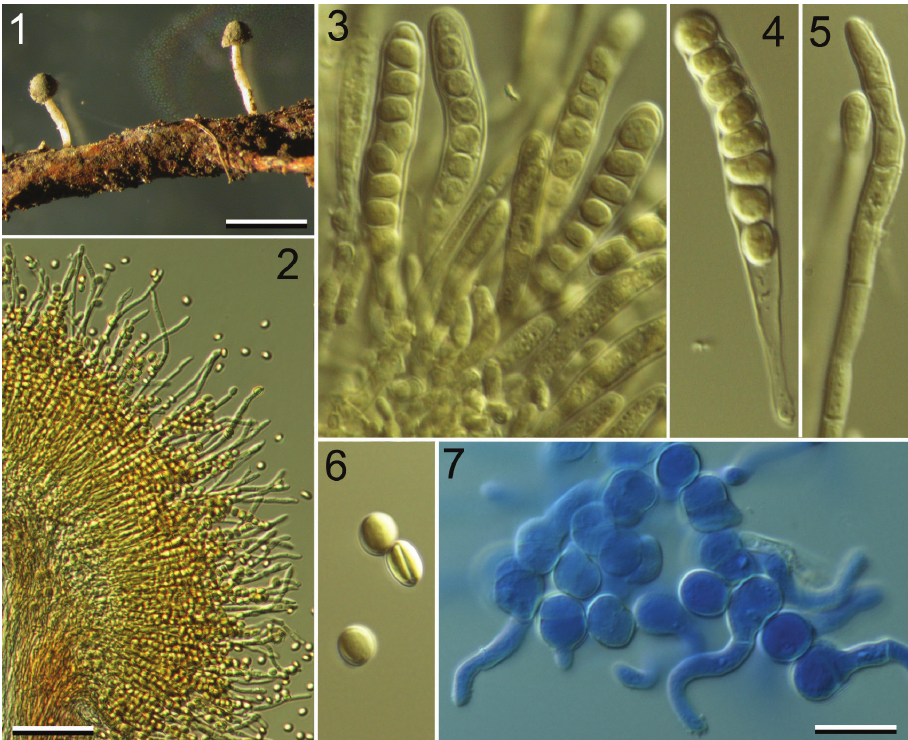
Figure 1. Roesleria subterranea (TNS-F-38701). 1 Growing habits of two mature mazaedia on the root tip of an unidentified tree 2 Hymenium of mazaedium, showing protruding paraphyses 3 Enlarged hy- menium showing developmental stages of asci and paraphyses 4 Mature ascus containing eight ascospores 5 Paraphysis 6 Discharged matured ascospores; on the right, a transversely one-septate spore is shown in side view 7 Germination of ascospores on MEYE, showing that germination tubes from one of the two-celled spores 2–6 Mounted in Meltzer’s solution 7 Mounted in lacto-aniline blue. Bars : 1 = 2 mm; 2 = 50 μm; 3–7 = 10